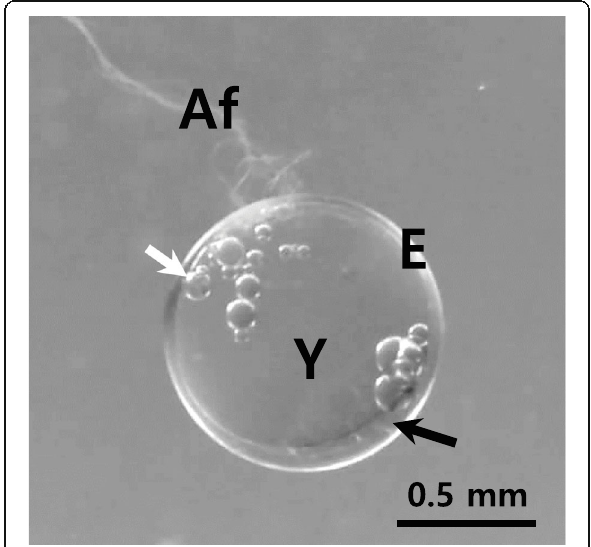
Fig. 1 Fertilized egg of dwarf rainbowfish ( Melanotaenia praecox ). White arrow; lipid droplets, E; egg envelope, Y; yolk. The perivitelline space (black arrow) was very small and a bundle of adhesive filament (Af) was only at the area of animal